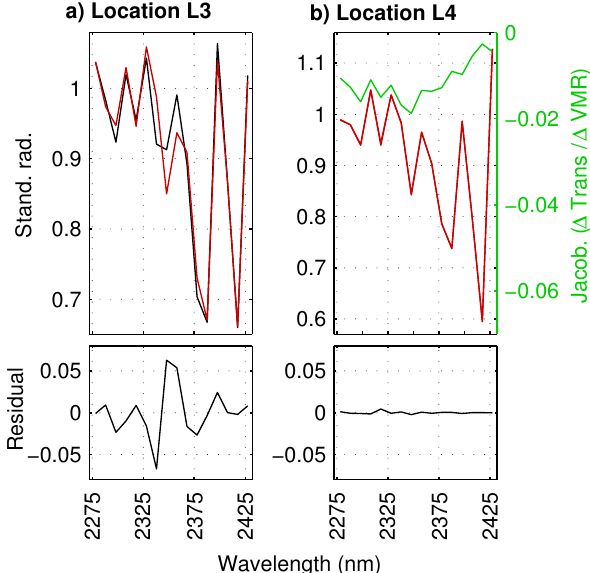
Fig. 13. (a) The modeled (red) and measured standardized radi- ance (black) for location L3, which corresponds to a dark spec- trum with an average radiance of 0.0376uWcm − 2 sr − 1 nm − 1 . L3 is located in a distinct region with high values for the standard deviation of the residuals (see Fig. 12c) and was excluded from the results shown in Fig. 12d. (b) For location L4, there is bet- ter agreement between modeled and measured radiance (average 0.5187uWcm − 2 sr − 1 nm − 1 ) . The CH 4 Jacobian for the lowest layer is overlain (green) to indicate the location of CH 4